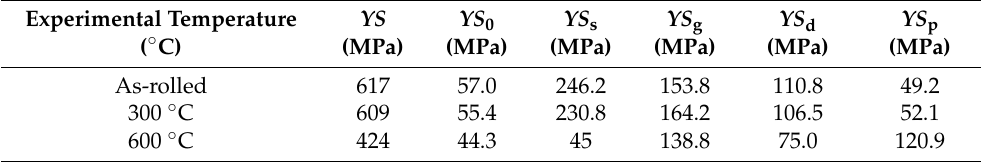
Table 4 lists the various strengthening contribution values at different temperatures.